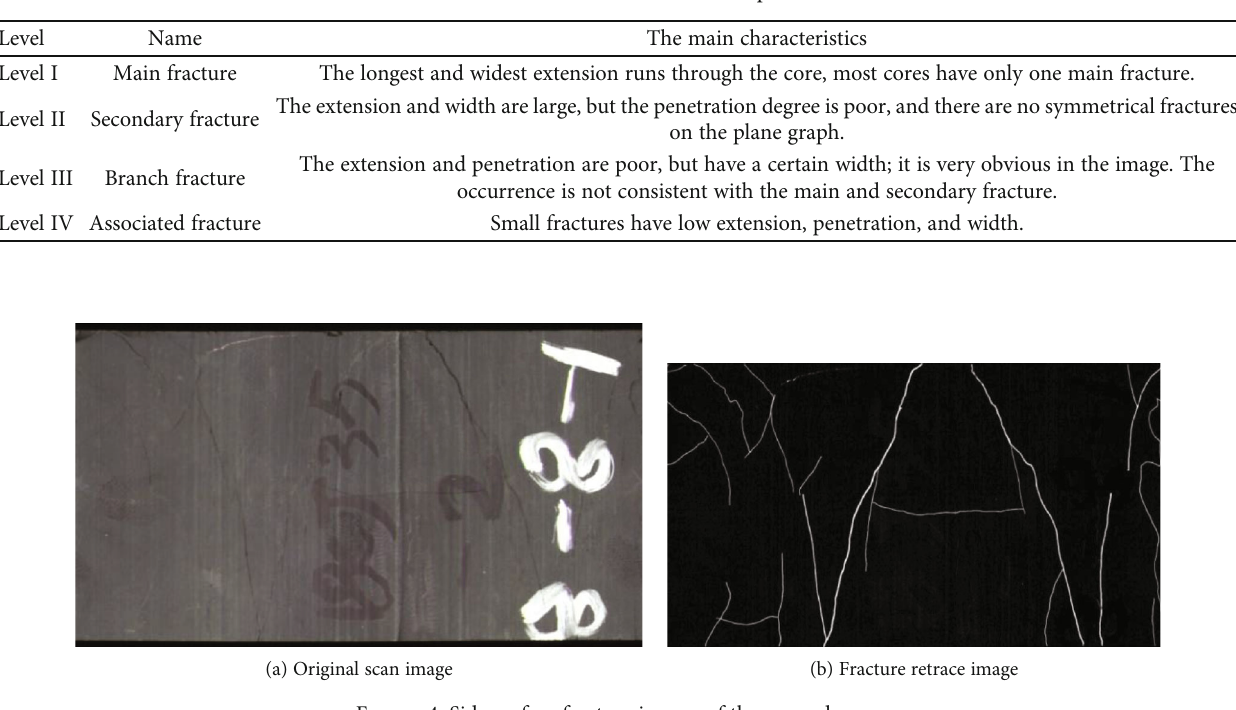
Table 2: Fracture classi fi cation table of the pressed core.